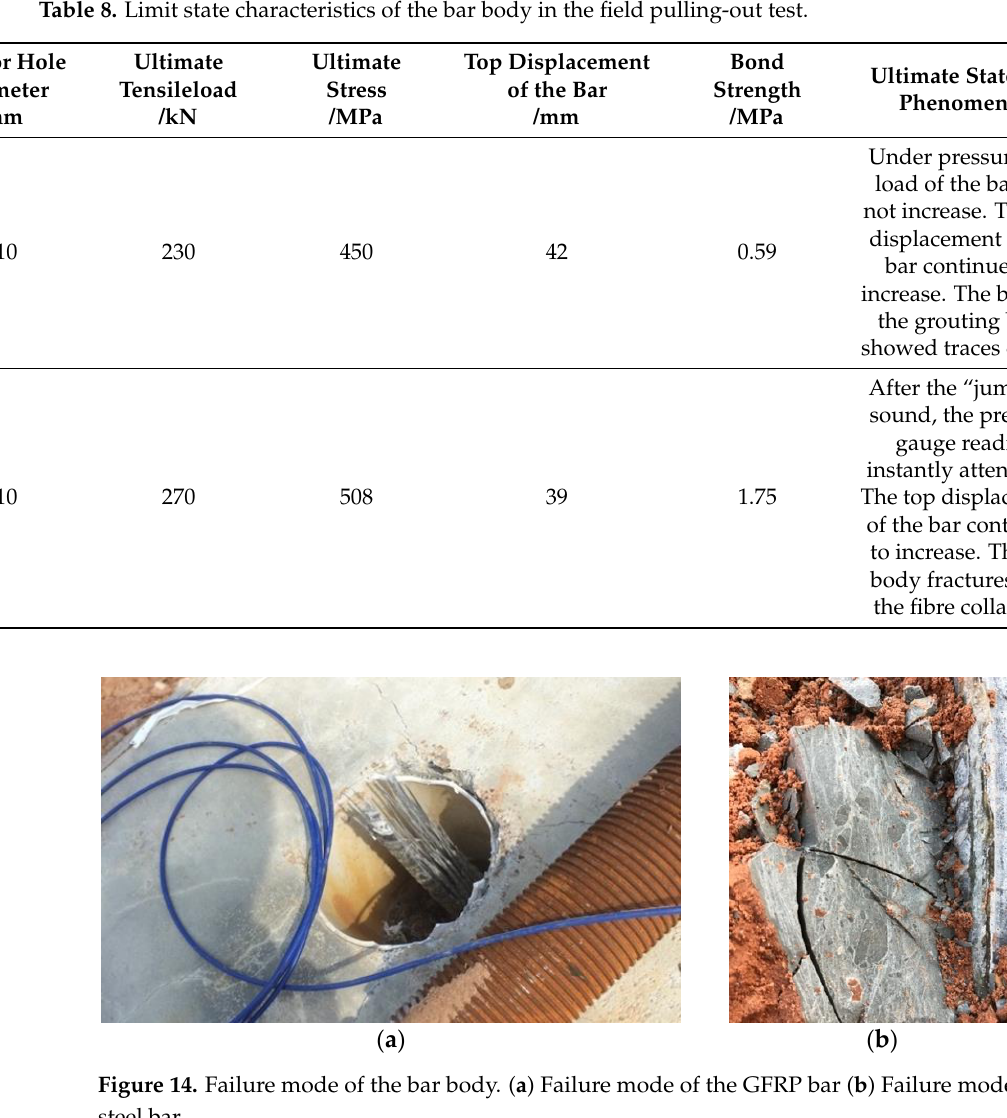
( b ) Figure 16. Schematic diagram of bars failure. ( a ) Schematic diagram of the steel bar failure. ( b ) Schematic diagram of the GFRP bar failure In conclusion, under the ultimate loading of the anchorage structure in soft rock, the steel bar with 450 MPa which is less than its ultimate strength shows the failure of bar body pulling-out, while the GFRP bar with 508 MPa shows the failure of bar body fracture. The GFRP withstands loading that is higher than the ultimate load reported by the man- ufacturer. Thus, GFRP bars can withstand a higher ultimate load than steel bars, and the bond strength of the interface between the bar and the grouting body is relatively high under the same condition. The steel bar anchorage structure in soft rock is destroyed at the interface around the grouting body, and that of the GFRP performs satisfactorily. 4. Suggestions For permanent anchors, due to factors such as groundwater level, they will bear more cyclic load. The performance of reinforced anchor bolts and GFRP under cyclic load is similar. Therefore, the corrosion resistance of GFRP provides guarantee for its durability. For temporary anchors, there are many cases of bearing constant load around the foundation pit. The good deformation coordination between GFRP bar and the grouting